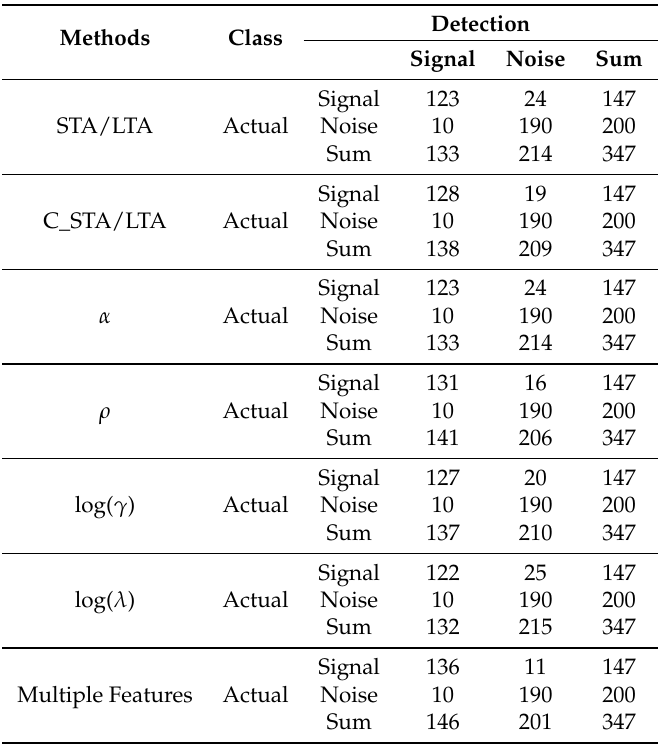
Table 5. Different methods test results.